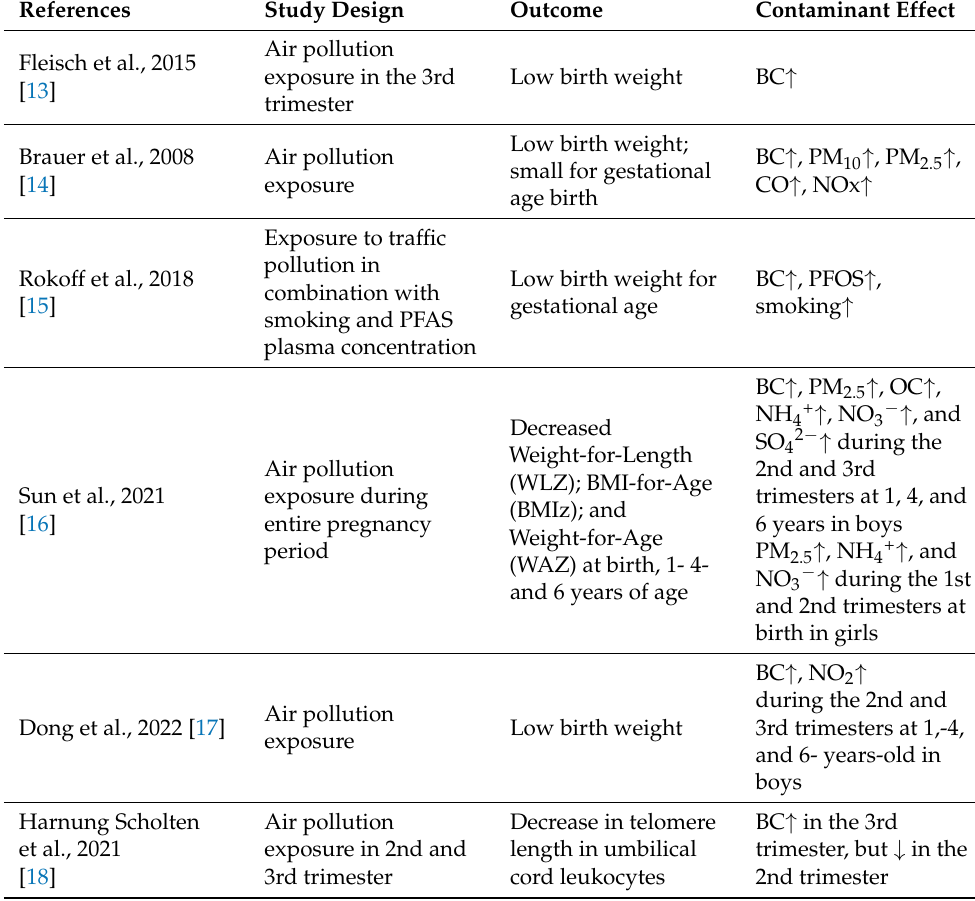
Table 1. Summary of prenatal air pollution and black carbon (BC) epidemiological studies (epidemio- logical, unless otherwise